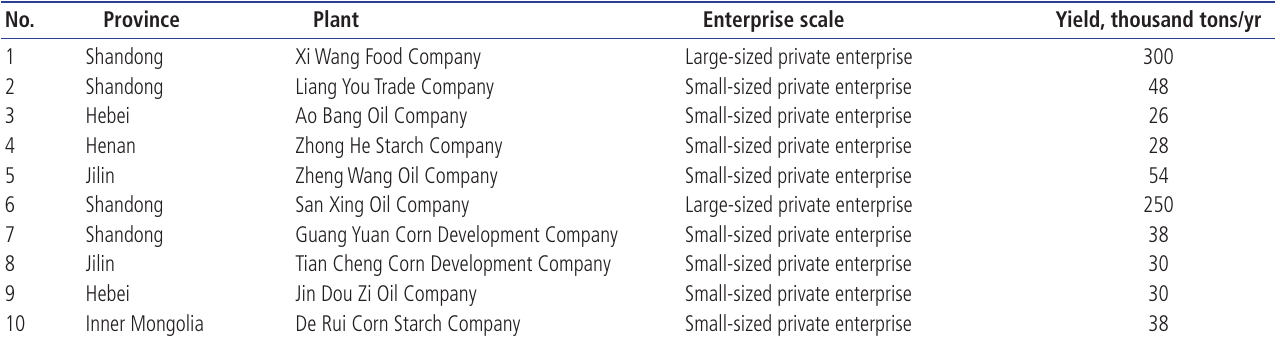
Table 1. Sources of corn germ meals